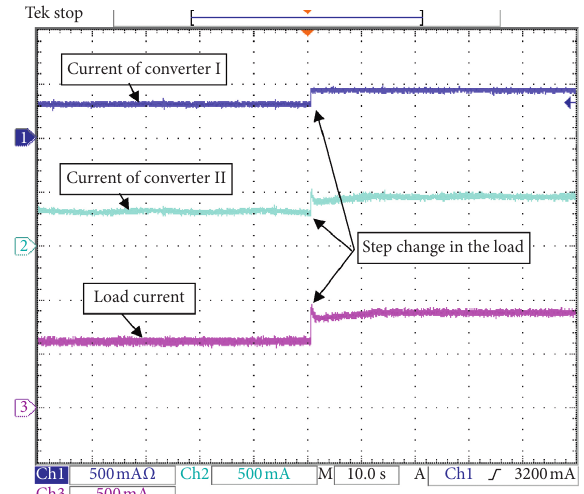
Figure 13: Output current waveforms for each converter and the total load current of the proposed